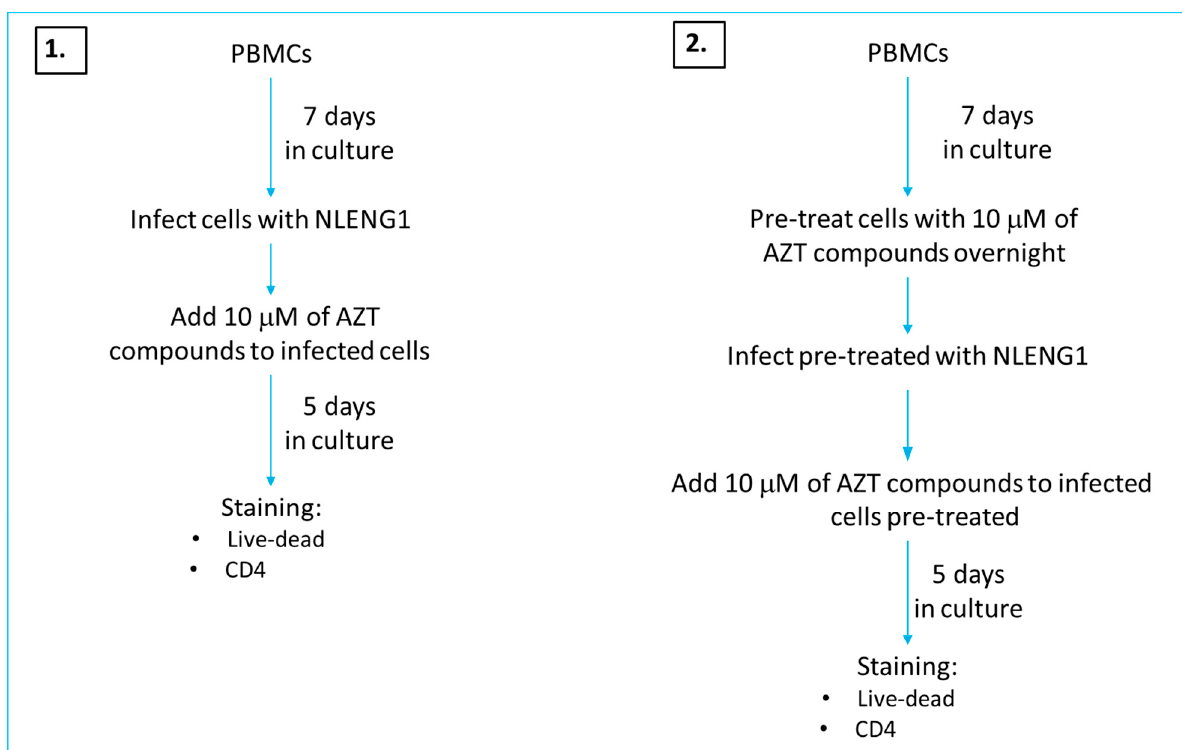
Scheme 2. Schematic representation of methodological approach. Human peripheral blood cells